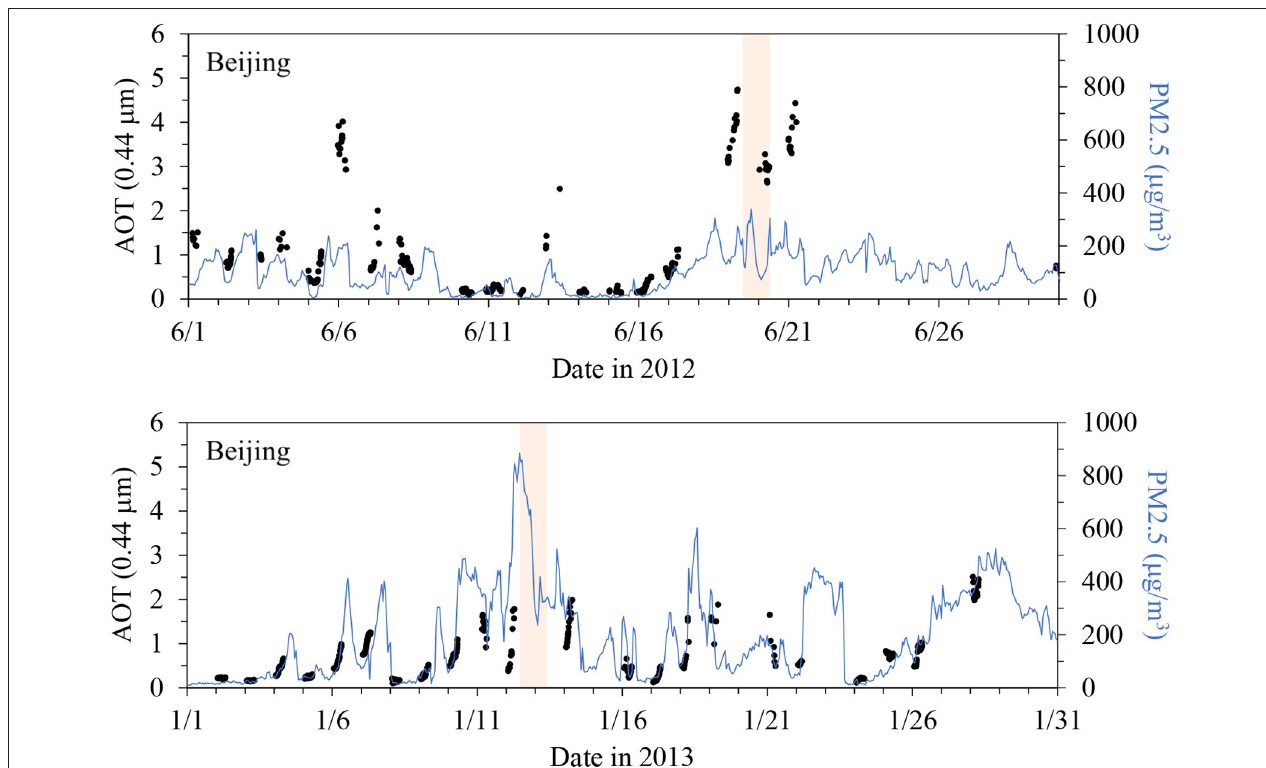
FIGURE 5 | The values of AOT at a wavelength of 0.44 µ m (black dots) observed at the Beijing NASA/AERONET site and PM 2.5 (blue solid curves) in July 2012 and January 2013. The PM measurements are obtained from the U.S. Department of State Air Quality Monitoring Program (http://www.stateair.net/web/post/1/1.html; accessed on November 15, 2011).